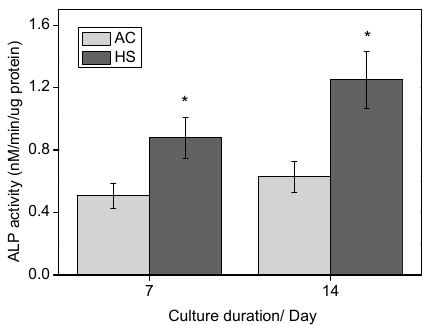
Figure 8. Alkaline phosphatase activities of cells on AC and HS specimens after seven and 14 days of culture. * Significantly different compared with AC.